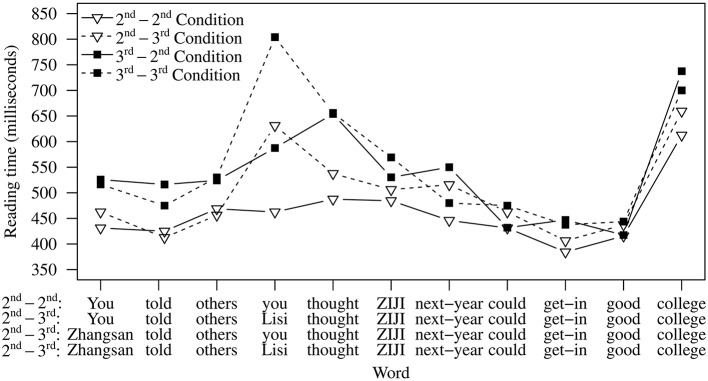
Experiment 2 average reading time data.